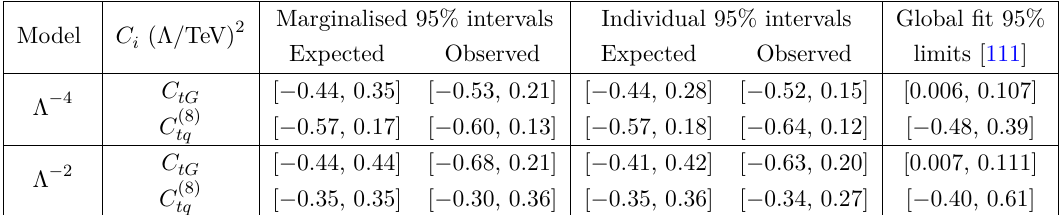
Table 5. Expected and observed 95% intervals for the Wilson coefficients ( C results show the intervals extracted from the nominal fit where both Wilson coefficients are allowed to vary. The individual intervals are extracted from fits where only the Wilson coefficient under study is allowed to differ from zero. The results are compared with the individual limits obtained in ref.